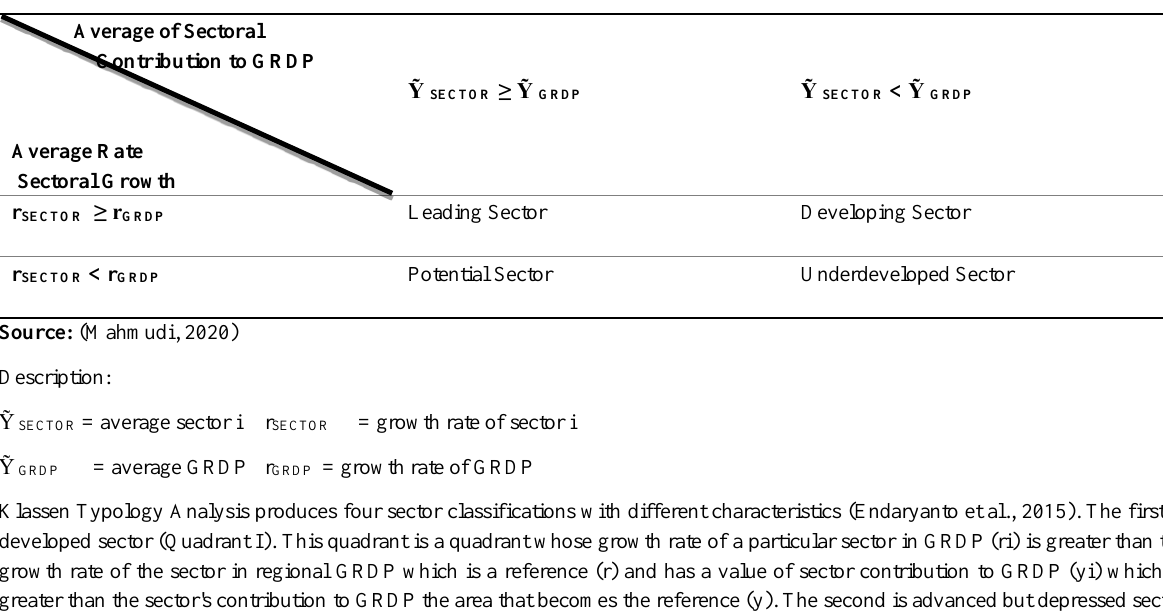
Table 1: Sector Category Based on Klassen